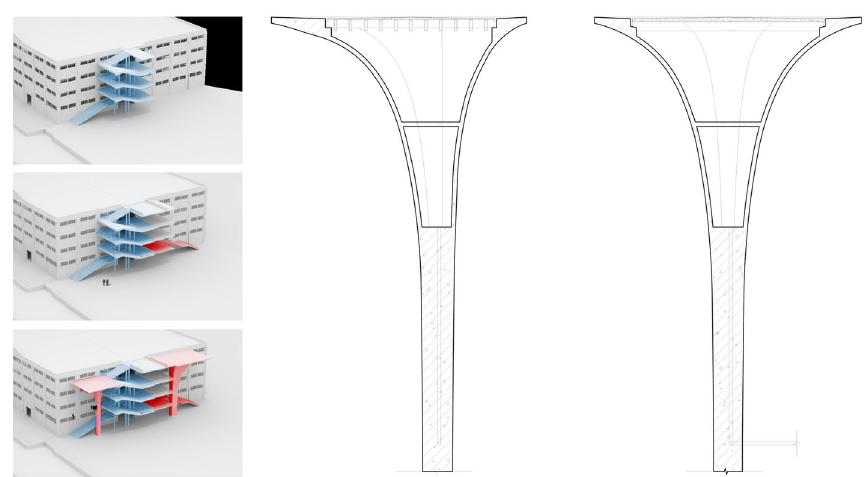
Fig. 16 Gigantic columns with built-in rainwater drainage system (Source: Archi-Union Architects)